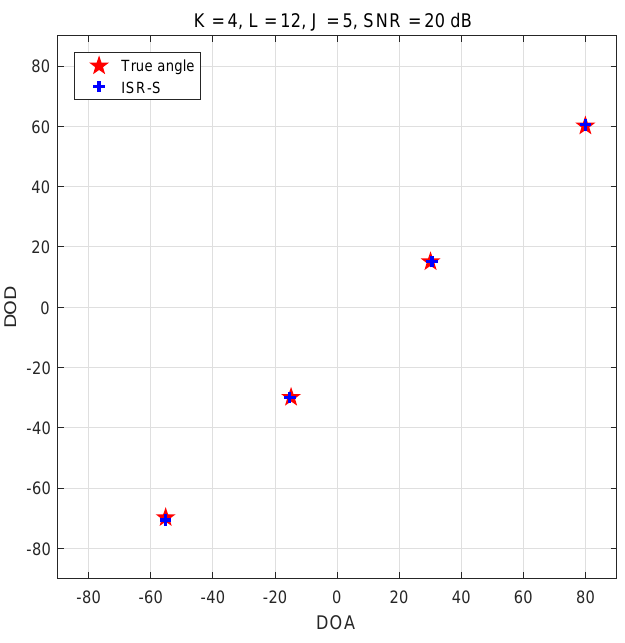
Figure 2. Target localization performance of the proposed ISR-S method, K = 4 is unknown.